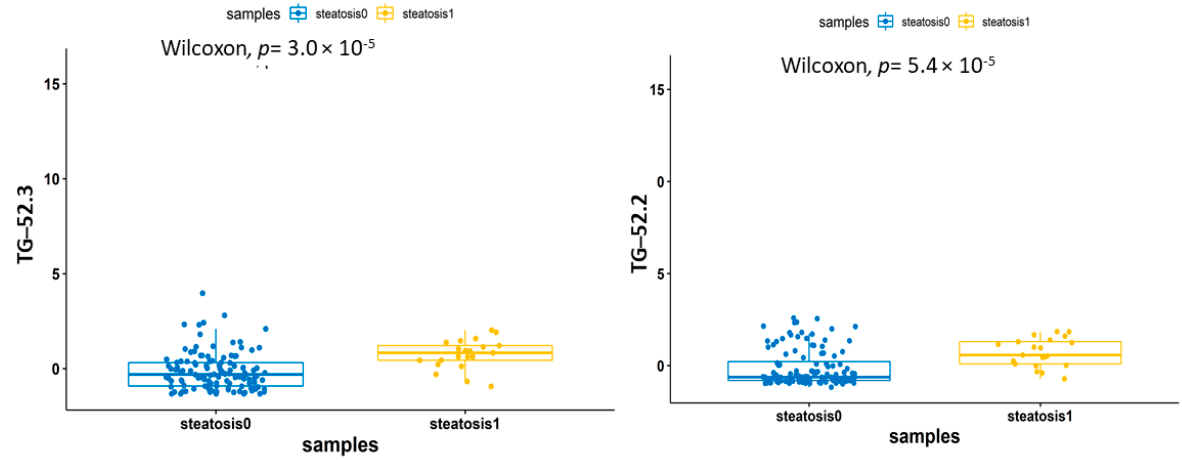
Figure 8. A boxplot denoting the upregulation of different lipid classes in steatosis1 when compared to steatosis0. The p value obtained from the Wilxocon test is significant.